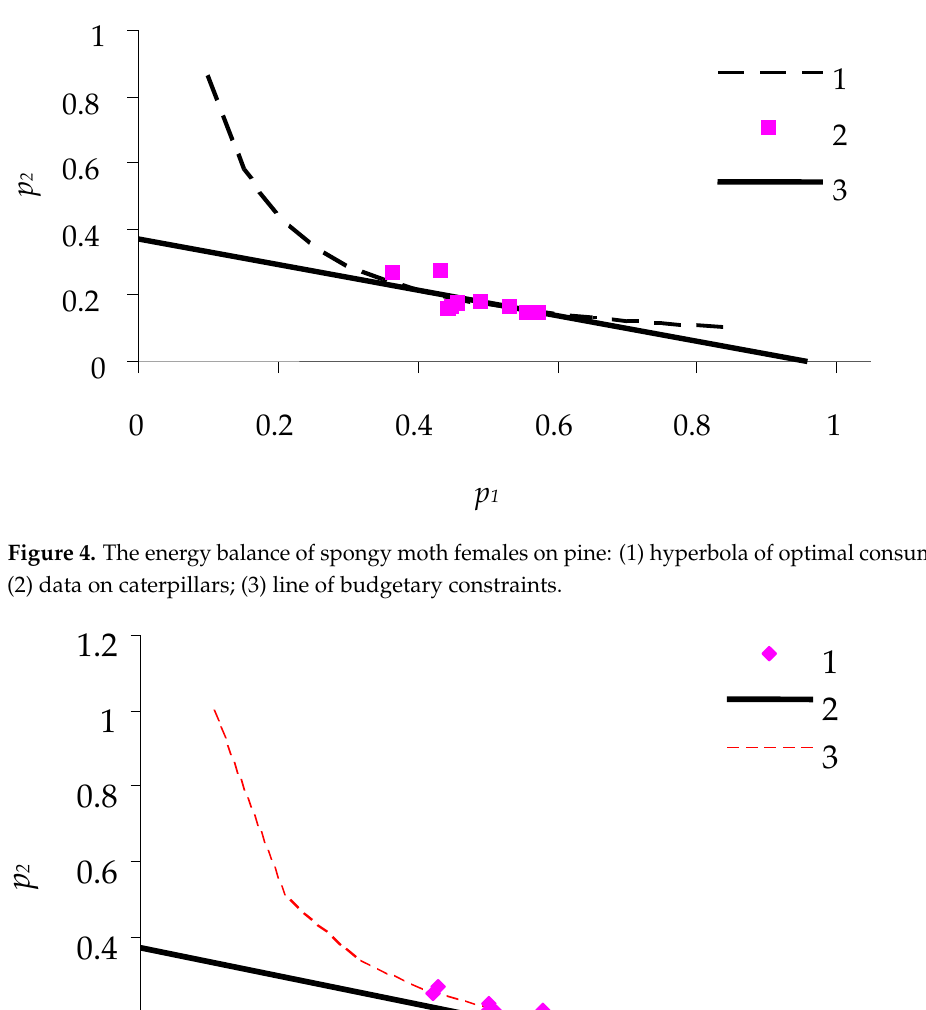
Table 1. Consumption model parameters for pupating females and males that fed on different types of feed. Errors refer to standard errors.